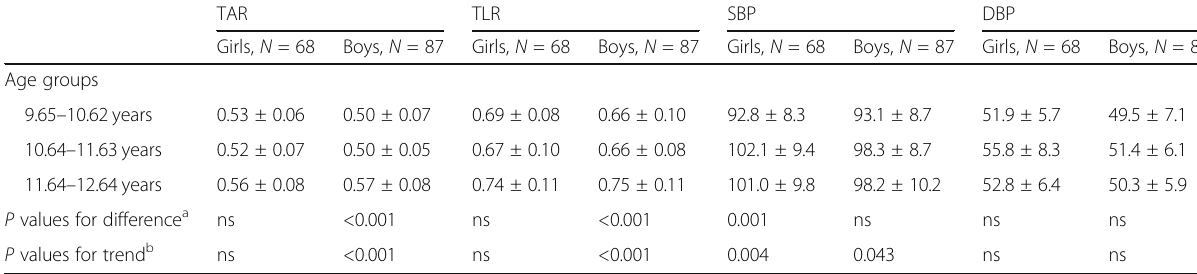
Table 2 Baseline values of fat distribution parameters and blood pressure stratified by age